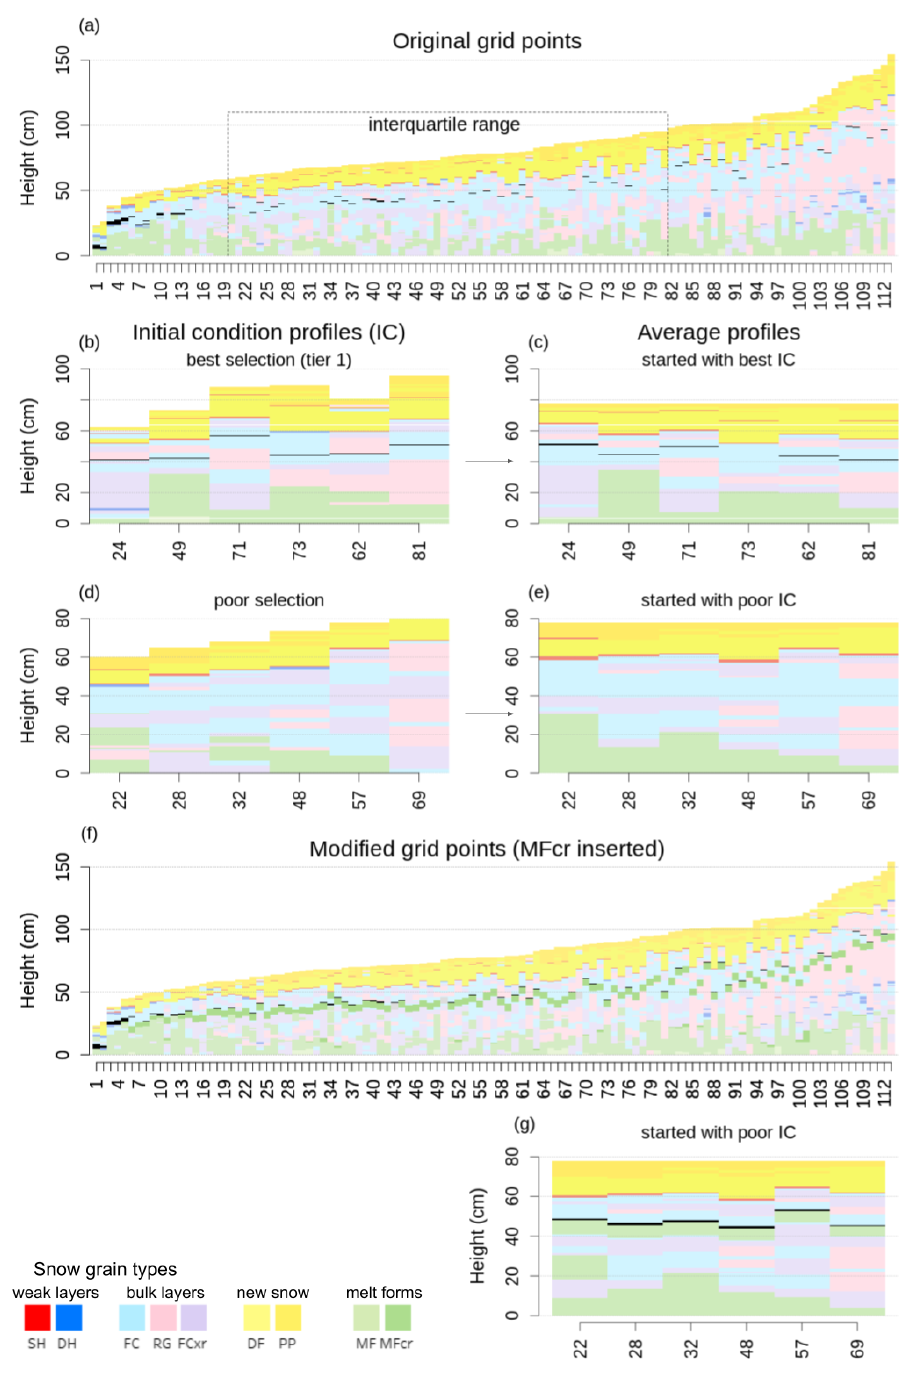
Figure 7. An experiment demonstrating the influence of the initial conditions. (a) The grain-type sequences of the original grid points with the interquartile range of snow height highlighted. A scarcely distributed weak layer that is located roughly 20cm below the new snow within the bulk layers is slightly emphasized by the more salient black colour in all panels. (b) The grid points chosen by the algorithm as most suitable initial condition profiles (tier 1). (c) The average profiles resulting from the tier 1 starting positions in (b) . (d) Less suitable starting positions that miss the weak layer within the bulk layers. (e) The average profiles resulting from the suboptimal starting positions in (d) , which also miss the particular weak layer. (f) The modified profiles from (a) with an artificially inserted crust in the bulk layers (also emphasized by stronger colour). (g) The average profiles resulting from the suboptimal starting positions in (d) when applied to the modified set of profiles in (f) ; they contain both the crust and the weak layer above. See text for more detailed explanation.